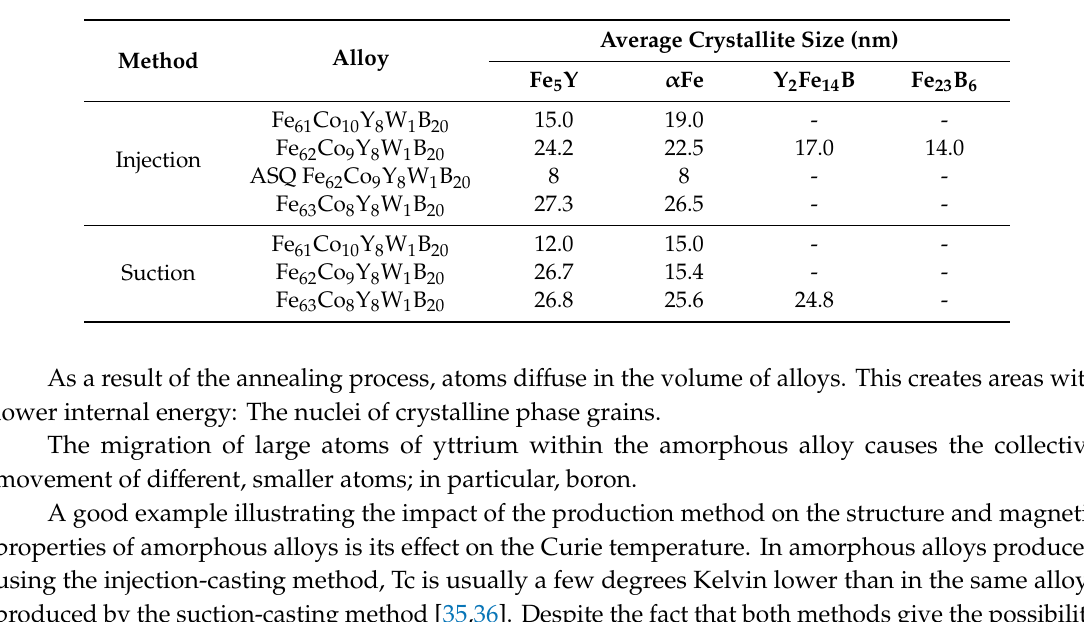
Table 1. Estimated average size of the crystalline grains for the alloys subjected to the thermal treatment (estimated error ~2